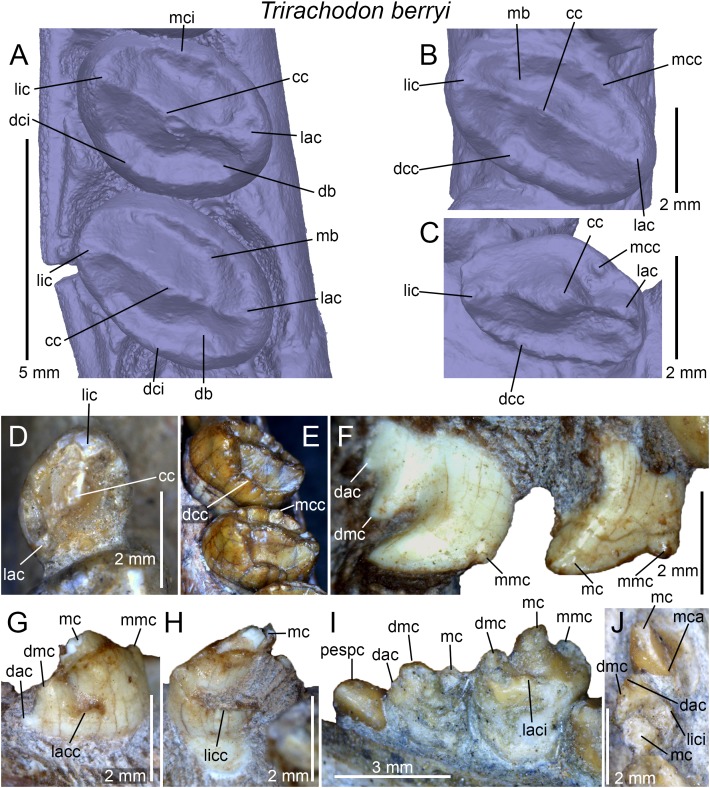
Dentition of Trirachodon berryi.(A) Fifth and sixth right lower gomphodont postcanines of SAM-PK-K171 in apical view; (B) penultimate and (C) ultimate (and basolingually rotated) right lower gomphodont postcanines of SAM-PK-K4801 in apical view; (D) first left lower gomphodont postcanine of BP/1/4658 in apical view; (E) fifth (bottom) and sixth (top) right lower gomphodont postcanines of SAM-PK-K171 in apicomesial view; (F) first (left) and second (right) right upper sectorial postcanines of SAM-PK-K4801 in labial view; (G and H) first right lower sectorial postcanine of SAM-PK-K4801 in (G) labial and (H) lingual views; (I and J) first and second (erupted and replacing tooth) right lower sectorial postcanines of BP/1/4658 in (I) labial and (J) apical views. Abbreviations: cc, central cusp; dac, distal accessory cusp; db, distal basin; dcc, distal cingular cuspule; dci, distal cingulum; dmc, distal main cusp; lac, labial cusp; lacc, labial cingular cuspule; laci, labial cingulum; lic, lingual cusp; licc, lingual cingular cuspules; lici, lingual cingulum; mb, mesial basin; mc, main cusp; mca, mesial carina; mcc, mesial cingular cuspule; mci, mesial cingulum; mmc, mesial main cusp; pespc, partially erupted sectorial postcanine.